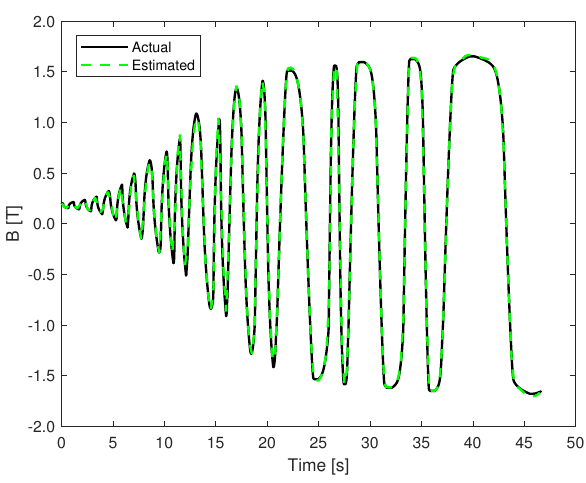
Figure 9. Predicted minor loop with random